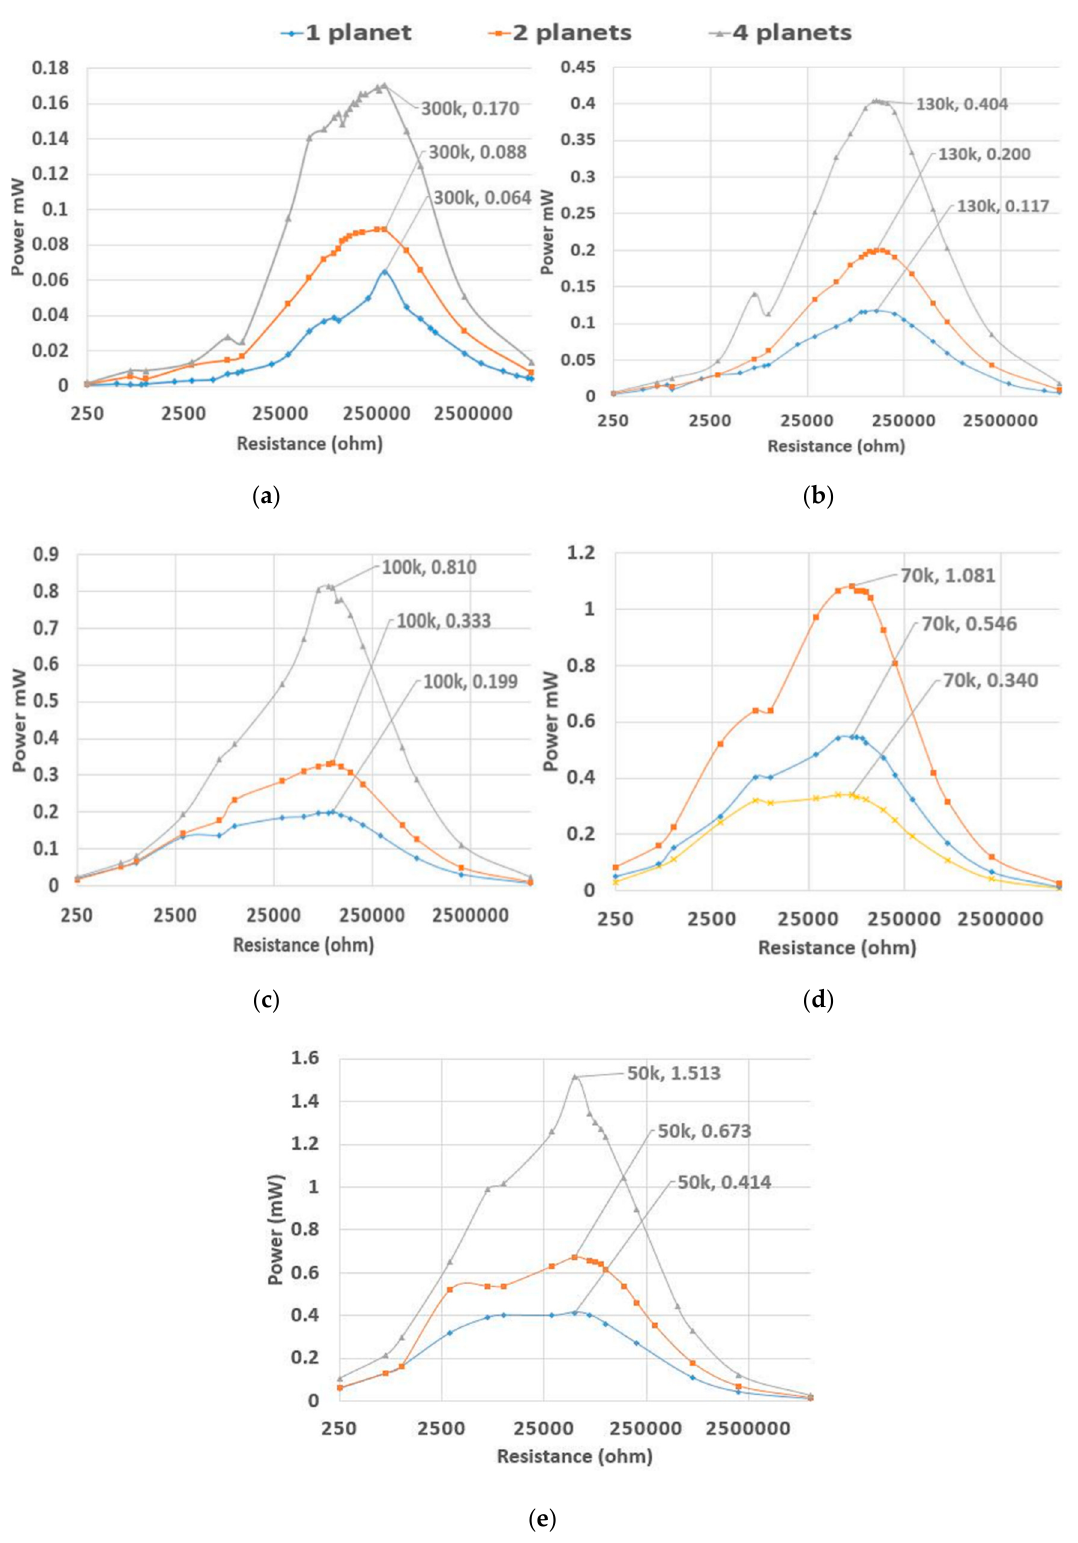
Figure 15. E ff ect of planet cover number increase on optimizing output power with di ff erent rotational Figure 15. Effect of planet cover number increase on optimizing output power with different speeds of ( a ) 300, ( b ) 600, ( c ) 900, ( d ) 1200 and ( e ) 1500 rotational speeds of ( a ) 300, ( b ) 600, ( c ) 900, ( d ) 1200 and ( e ) 1500 rpm.